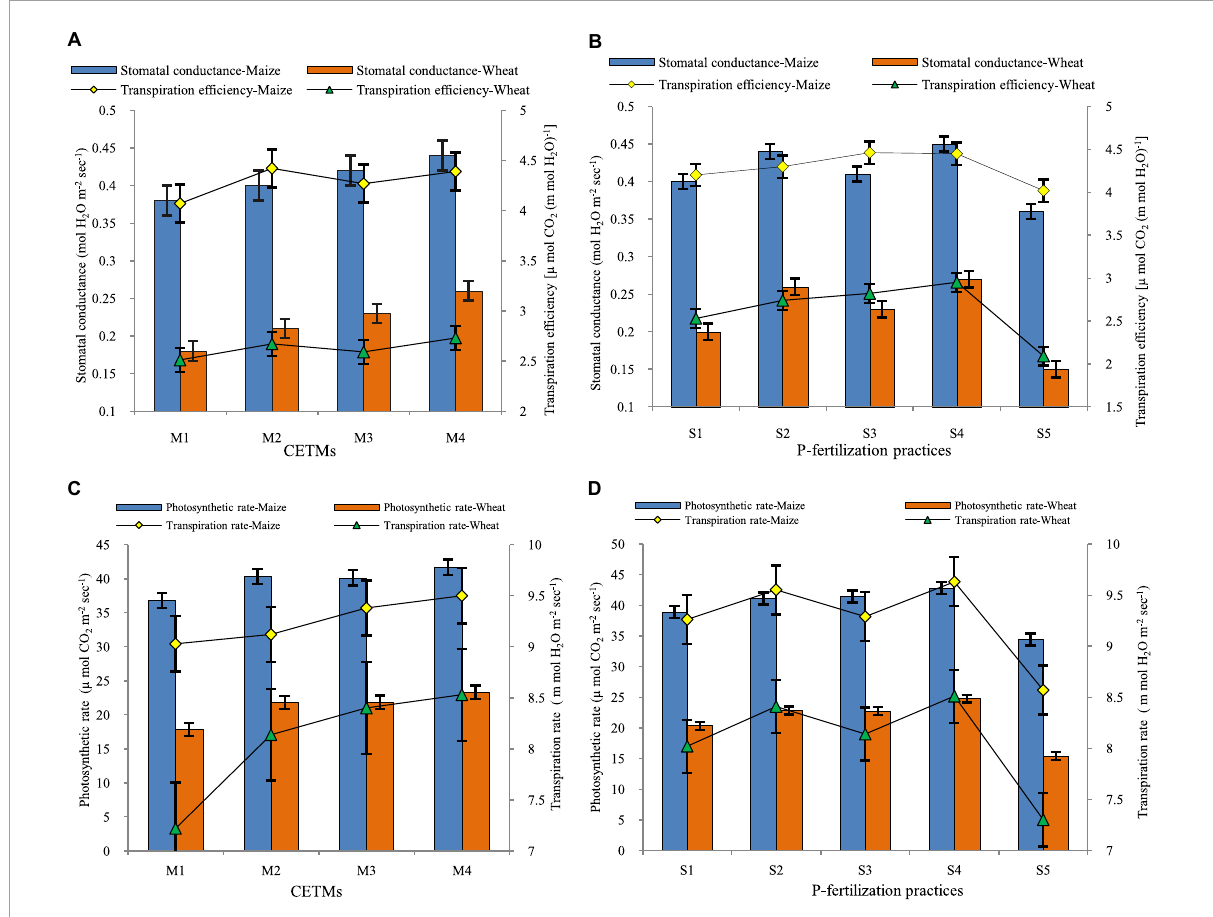
FIGURE3 Effect of crop establishment and tillage management (CETM) and P-fertilization practices on (A,B) stomatal conductance and transpiration efficiency; (C,D) photosynthetic rate and transpiration rate at flowering stage of maize and wheat under MWCS. The vertical bars represent LSD 0 . 05 values. M 1 , flat bed–conventional tillage (FBCT) both in maize and wheat; M 2 , raised bed–CT (RBCT) in maize and RB–zero tillage (RBZT) in wheat; M 3 , FBZT both in maize and wheat; M 4 , permanent raised bed–ZT (PRBZT) both in maize and wheat. S 1 -P 100 , 100% P as basal; S 2 -P 50 + 2FSP, 50% P as basal (P 50 ) + 2 foliar sprays of phosphorus (2FSP) as DAP (2%) at knee-high stage (KHS) and pre-tasseling stage (PTS) in maize and at tillering stage (TS) and pre-flowering stage (PFS) in wheat; S 3 -P 50 + PSB + AMF, P 50 + PSB + AM-fungi (AMF); S 4 -P 50 + PSB + AMF + 2 FSP, P 50 + PSB + AMF + 2FSP at KHS and PTS in maize and at TS and PFS in wheat; S 5 -P 0 , 100% N and K with no P (P 0 ) as